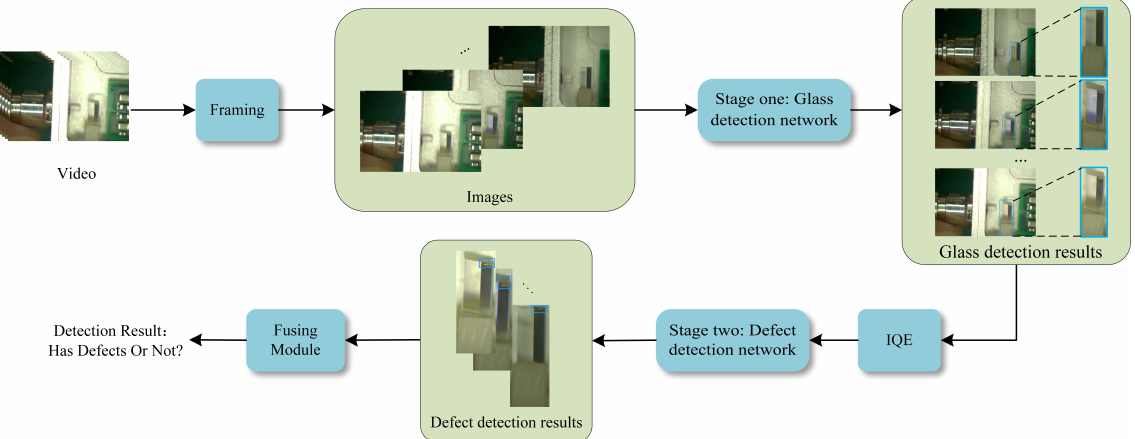
Figure 2. Flowchart of proposed optical glass defect detection methods. First of all, multi perspectives images are extracted from the videos of optical glass. Then glass detection stage takes these images as input to find the locations of optical glass. The detected regions that cover the optical glass with good image quality will be fed into the defect detection stage. Finally, the fusing module is proposed to integrate the results from different perspectives to get the final defect detection